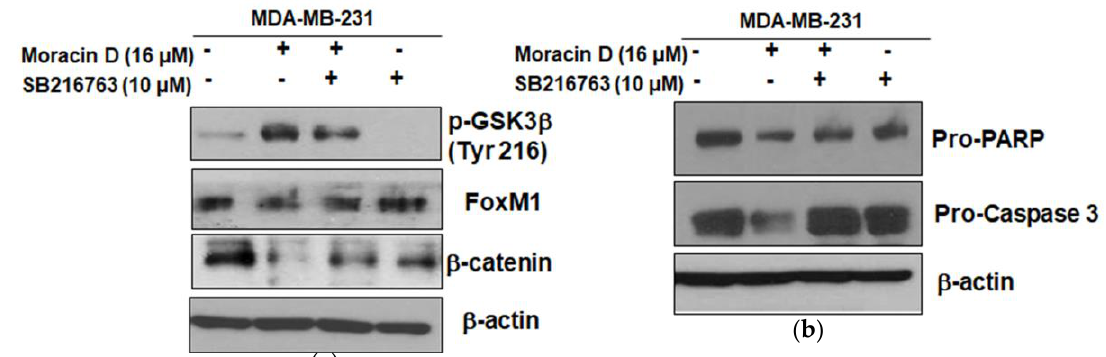
Figure 5. Effect of GSK3β inhibitor SB216763 on pro-PARP, pro-caspase3, FOXM1, and β-catenin in Moracin D treated MDA-MB-231 cells. Cells were treated with Moracin D (16 μM) for 24 h one hour after pre-treatment with 10 μM SB216763 GSK3β inhibitor. Then, Western blotting was performed for FOXM1, β-catenin ( a ), pro-PARP, and pro-caspase3 ( b ).